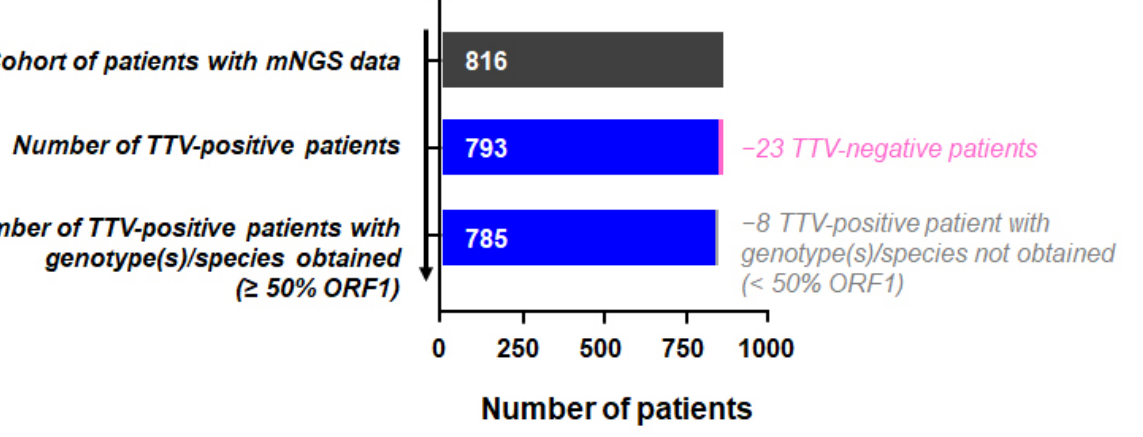
Figure 1. Flowchart of study and TTV analysis.